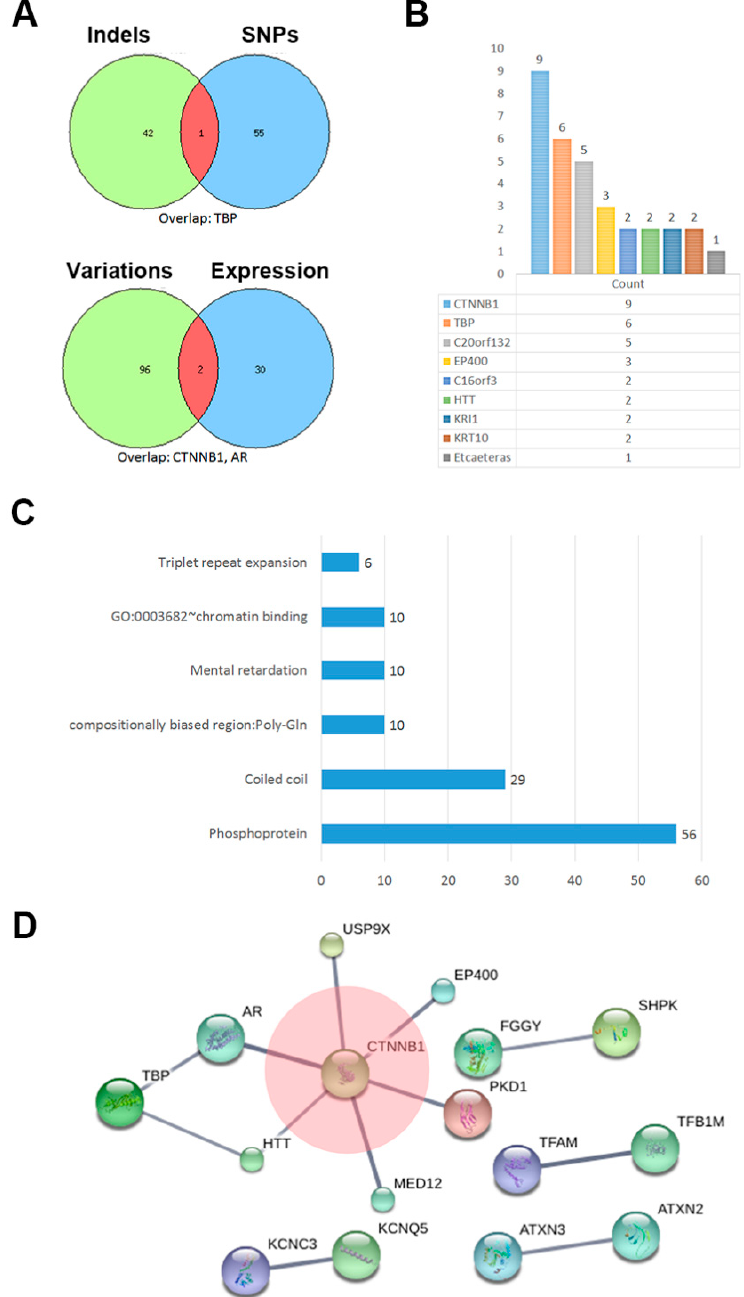
Figure 3. Combined set of variated genes: ( A ) Comparison of indels with SNPs involved genes ( top ) and present combined set with previously reported abnormally expressed genes ( bottom ) in SPN; ( B ) the variation events count of each homologous gene; ( C ) functions and pathways enrichment of combined variation events; and ( D ) network analysis according to String database.